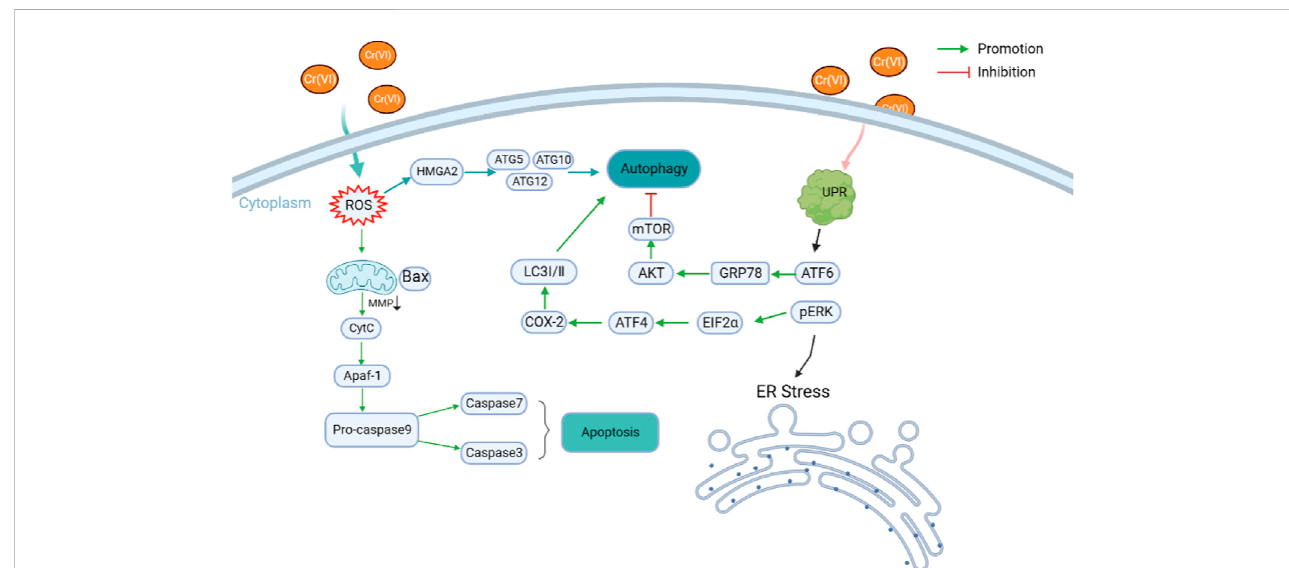
FIGURE 1 Mechanism of chromium toxicity in cells. The entry of Cr(VI) into cells induces a series of responses, including ER stress, autophagy and apoptosis, and these pathways also interact with each other through certain